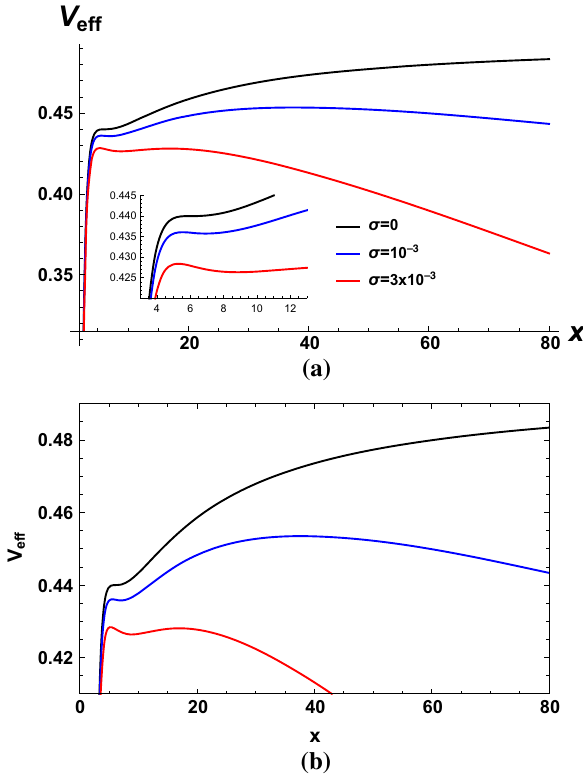
Fig. 1 Variation of the effective potential with x . Here we fix l 2 = α 2 = 0 . 01. The corresponding ISCO position gets far- 12 ( 1 − α 2 ) 2 and ther and farther from the central black hole, as the deviation from GR increases. This becomes a bit more evident by looking at the smaller graph on the panel a , where the minima of the effective potential moves slightly to the right for increasing values of σ . Moreover, the modifica- tion of the gravity gives rise to maximum points for the V eff curve. The greater are the σ values, the closer such points are to the event hori- zon. Panel b illustrates more clearly the appearance of these maximum points in the blue and red curves , indicating that extra unstable orbits can also exist along with the stable